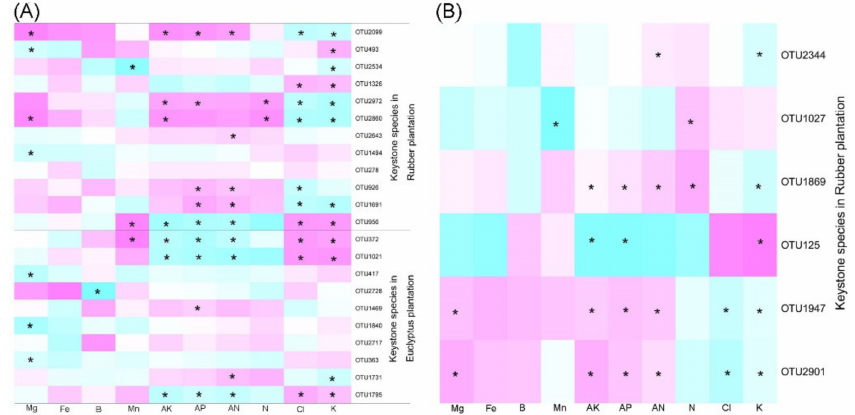
Figure 9. Spearman correlation heatmaps showing the relationships between soil microbial network keystone taxa and soil physiochemical variables. ( A ) The relationships between soil bacterial network keystone taxa and soil physiochemical variables. ( B ) The relationships between soil fungal network keystone taxa and soil physiochemical variables. Asterix indicates significant correlations at the p < 0.05